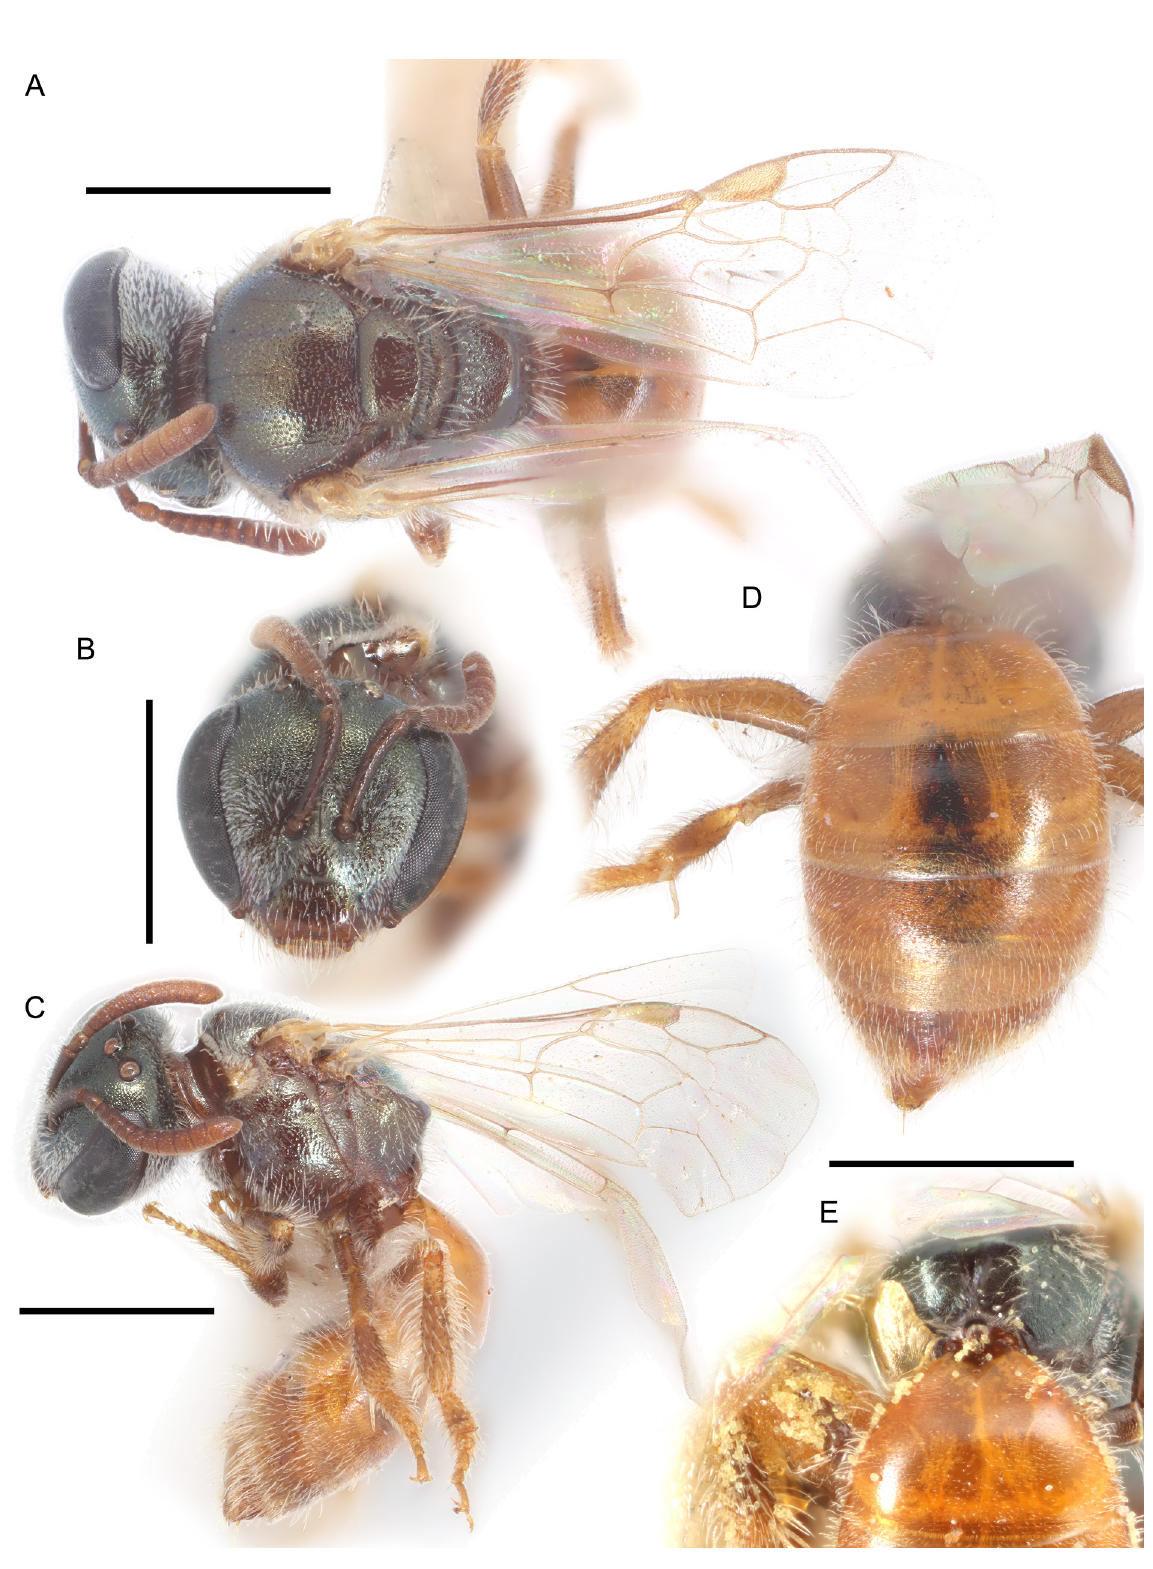
Fig. 13. Lasioglossum ( D. ) austerum sp. nov., ♀. A . Dorsal habitus. B . Face. C . Lateral habitus. D . Metasoma. E . Propodeum. Scale bars: 1